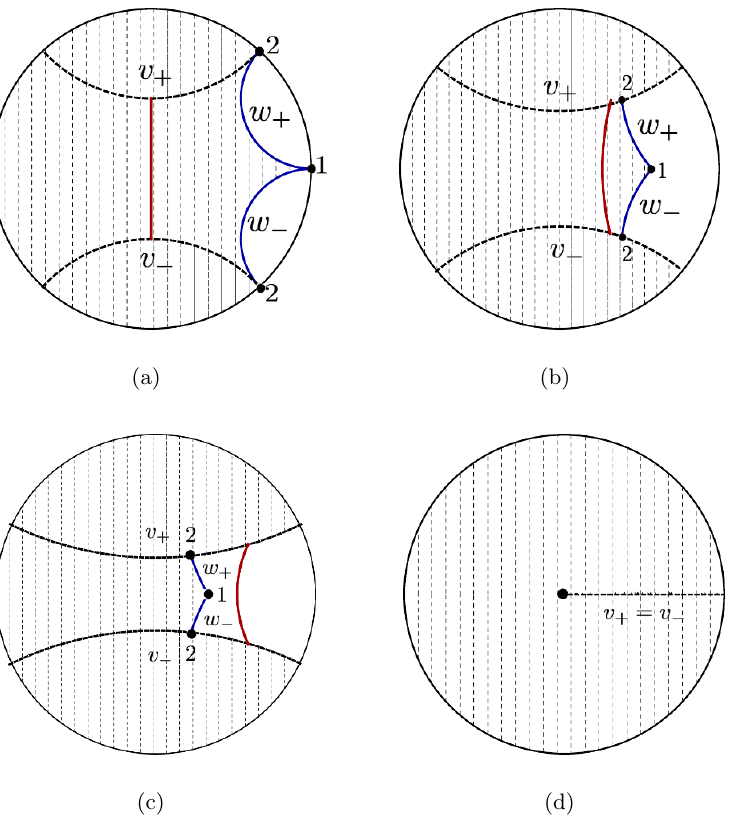
Figure 3 . Collision of particles in the BTZ rest frame. The dark red curve represents the horizon of the black hole which is about to form. The dark red curve is the apparent